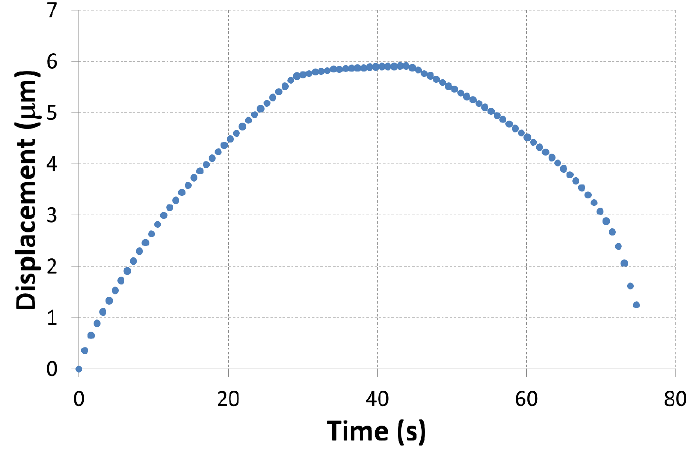
Figure 18. Displacement–time boundary condition applied to the numerical model.